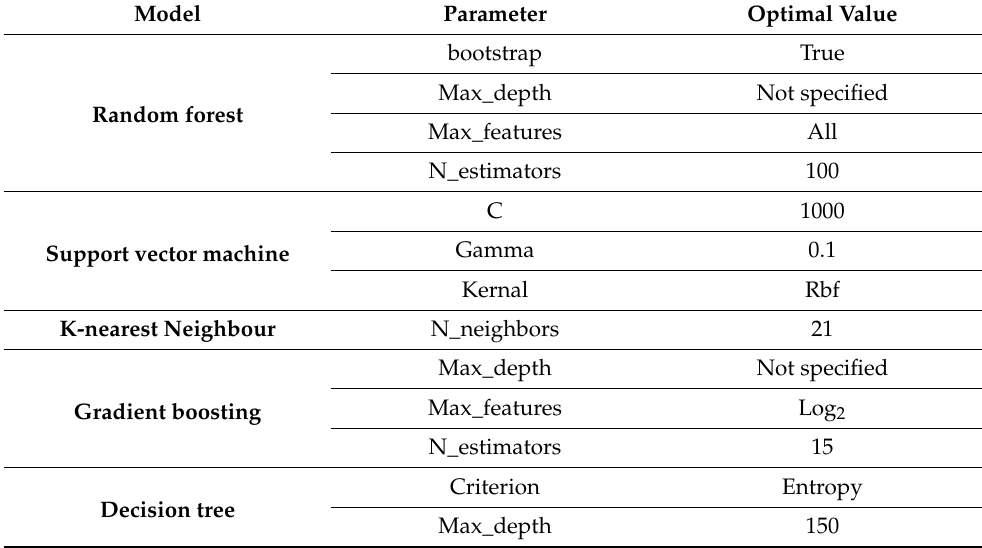
Table 2. Optimal values.